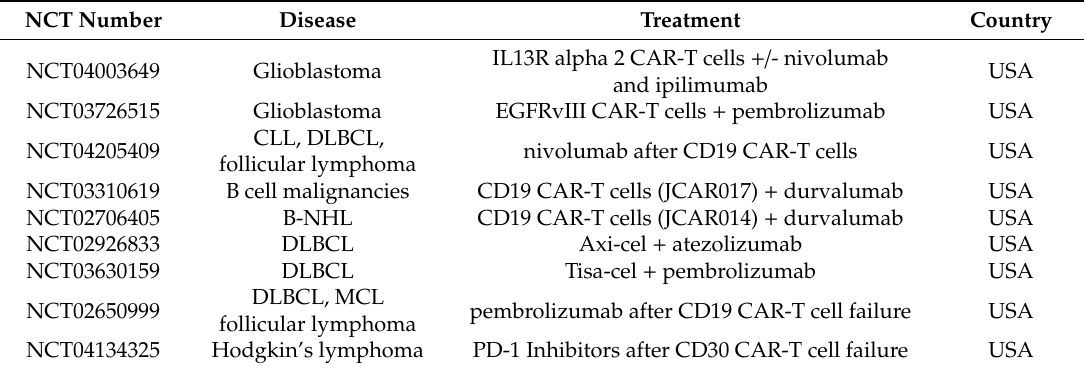
Table 2. Ongoing trials with chimeric antigen receptor (CAR)-T cells in combination with infused checkpoint inhibitors (www.clinicaltrials.gov, access date: 01 / 30 /